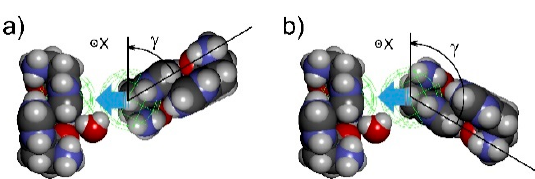
Figure 8. Possible arrangements of two adjacent molecular chains generated by 180-degree rotation of the second chain ( a ) and ( b ). The chains are viewed end-on indicating possible location of a water molecule.